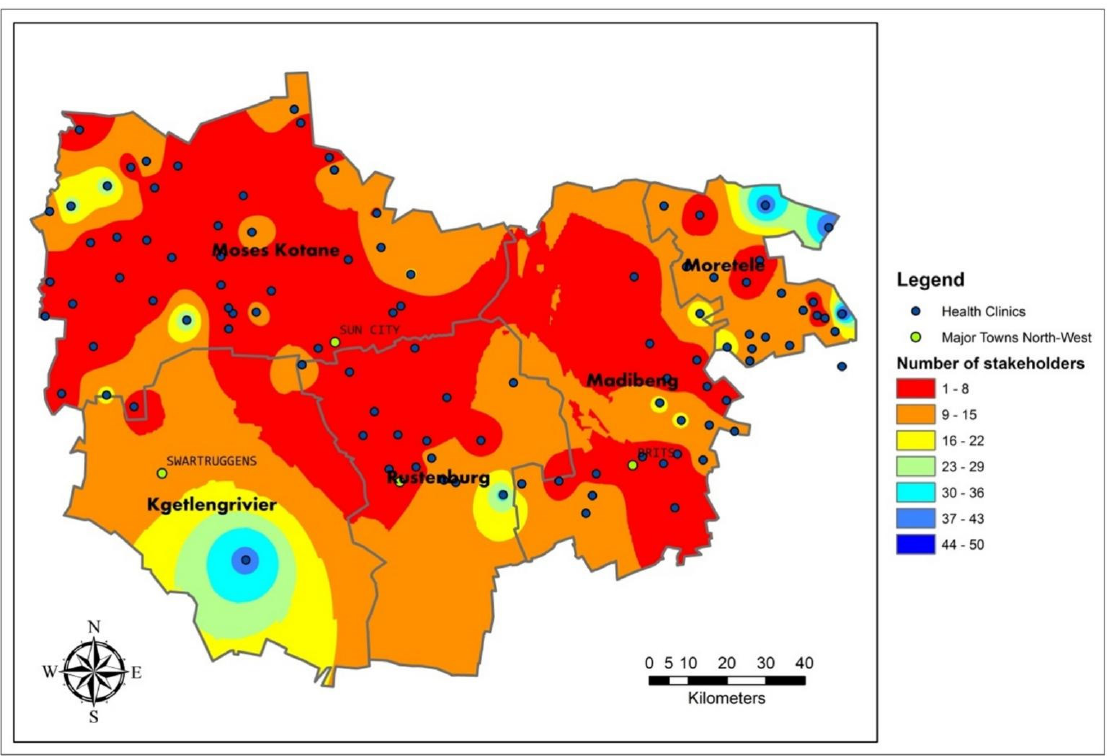
Figure 3. Abundance of stakeholders involved in health clinic gardens across all municipalities in the Bojanala district.